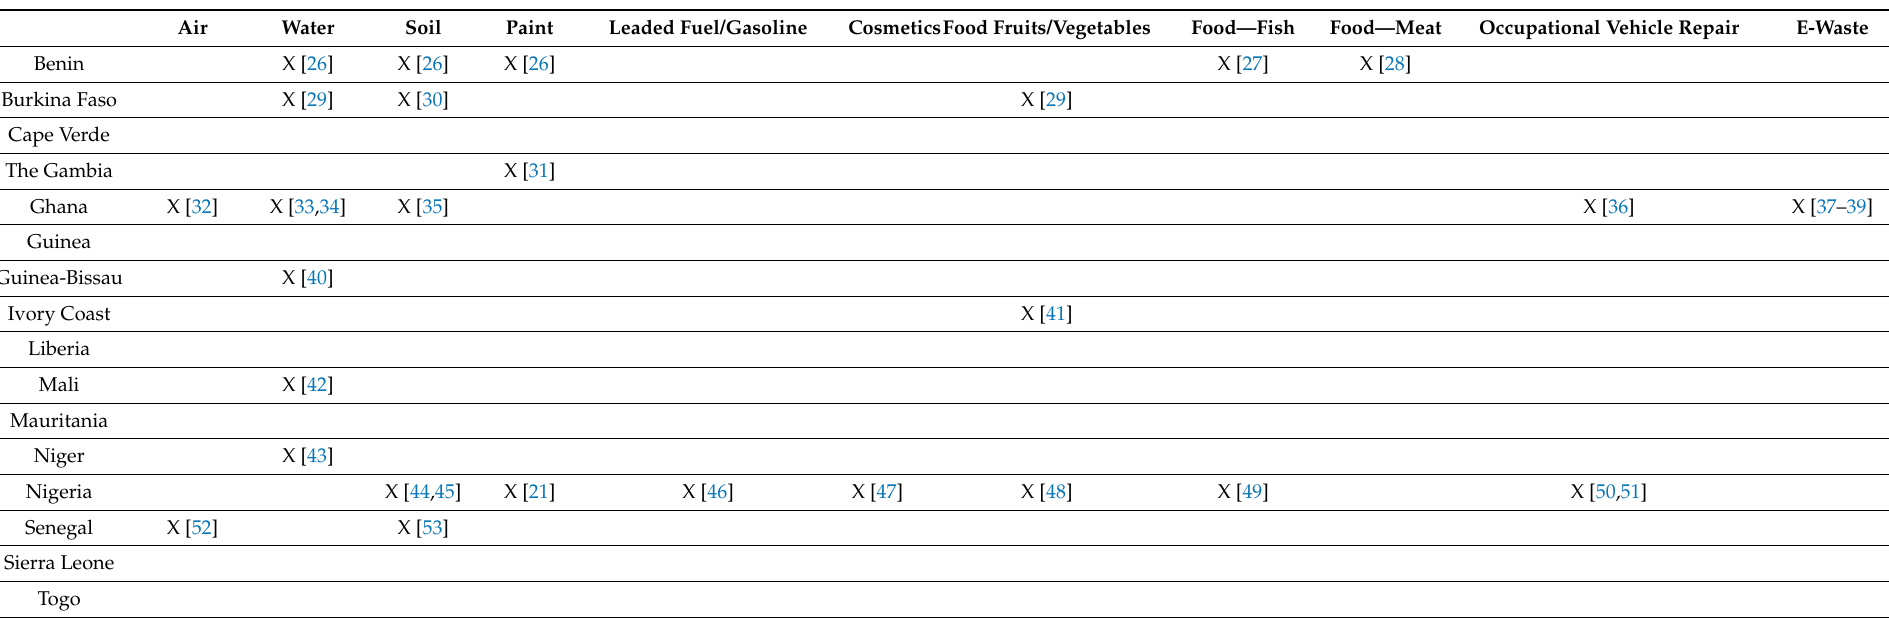
Table 1. Exposure type in West African region by